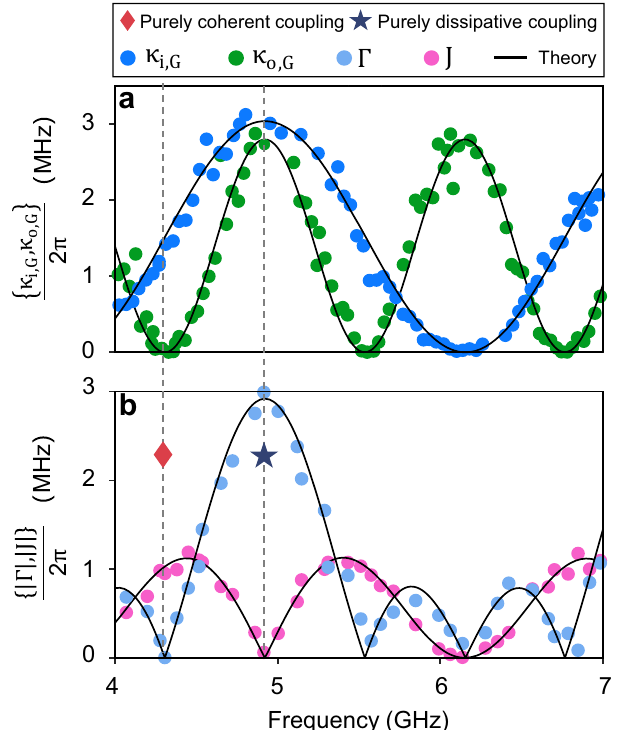
Fig. 3 | Decay rates and coupling strengths of the nested two giant spin ensemblesatdifferentfrequencies.a Thedotsarethedecayratesoftheinnerand outer GSEs measured at different frequencies. The solid curves are theoretical resultsobtainedusingEq.(4). b Thedotsaretheexperimentaldataofthecoherent interaction strength (pink) and dissipative interaction strength (light blue). The solid curves are theoretical results obtained using Eqs. (6) and (7). Two speci fi c cases are labeled by pentagram and rhombus, which indicate that the coupling betweenthenestedtwospinensemblesarepurelydissipativeandpurelycoherent,